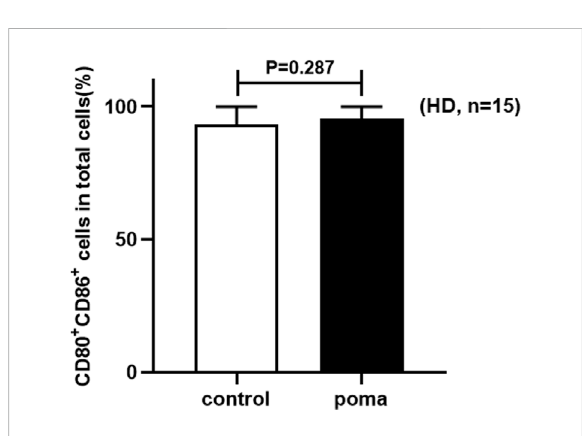
FIGURE 4 The comparison of the proportion of CD80+ CD86+ cells in total cells between the pomalidomide group and the control group in HDs.